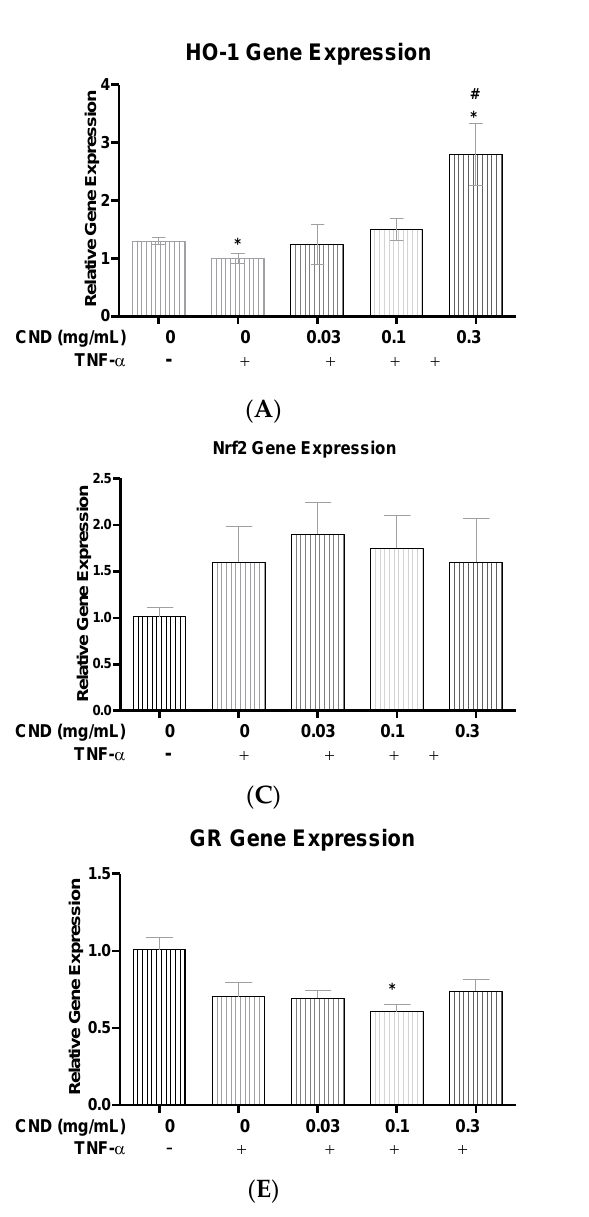
Figure 5. qRT-PCR Phase II antioxidant enzyme gene expression. HMEC-1 cells underwent treatment with 10 ng/mL of TNF-α as indicated with the presence or absence of 0.03, 0.1 or 0.3 mg/mL of CNDs for 6 h. After treatment, cells underwent RNA extraction, cDNA synthesis, and qRT-PCR. ( A ) HO-1, ( B ) NQO1, ( C ) Nrf2, ( D ) AR, ( E ) GR, ( F ) GCLC. Genes displayed no significant change in expression. All data represent mean ± SEM. (n = 3–6, * p < 0.05 vs. control, # p < 0.05 vs. TNF-α).